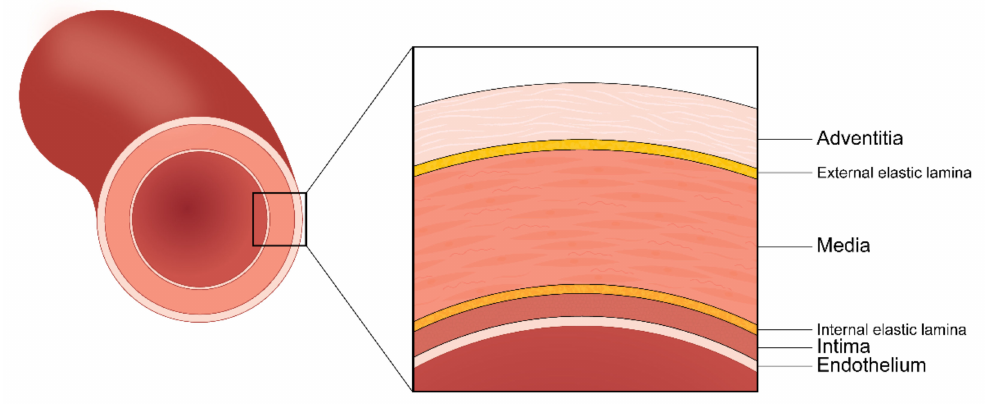
Figure 1. Multi-layered structure of a typical aortic wall.